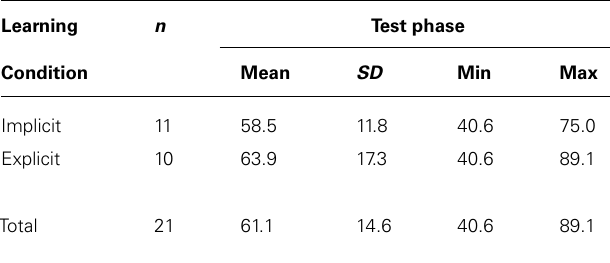
Learning n Test